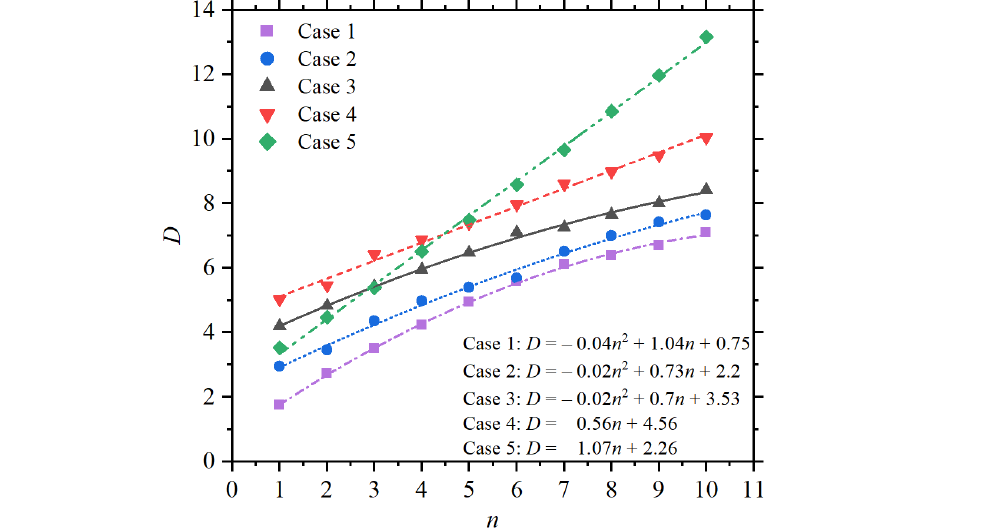
Figure 7. Directivity D as a function of the number of directors n for Cases 1 to